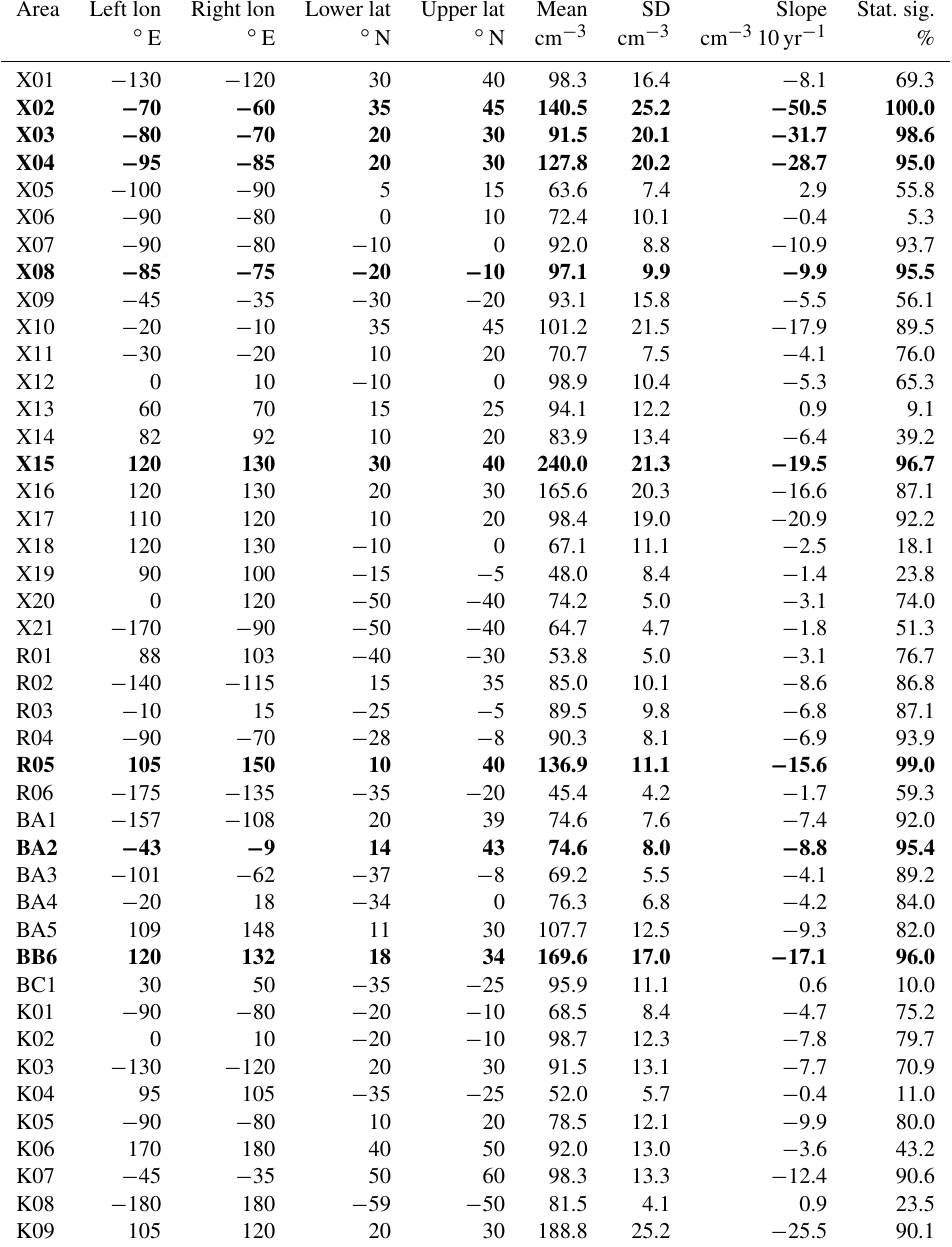
Table 3. For all areas shown in Fig. 9, this table lists the latitude–longitude boundaries, mean CDNC, standard deviation of CDNC, regression slope of CDNC against time, and the statistical significance of the slope. Rows in bold font have a significance level higher than 95%. The regression slope was calculated on monthly CDNC anomalies. The monthly CDNC anomalies were calculated by subtracting from each individual month the 13-year mean value of that same